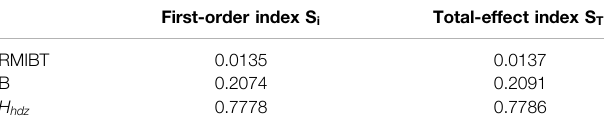
TABLE 2 | Results of the sensitivity